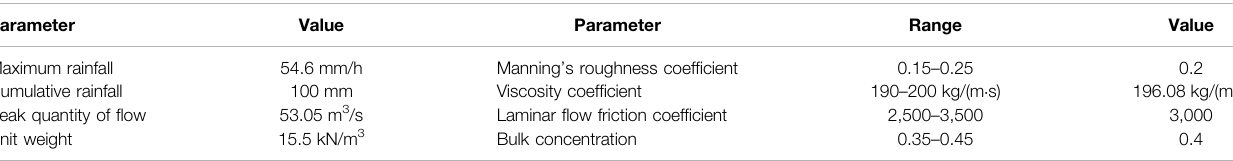
TABLE 1 | Parameters used in numerical simulation by FLO-2D.